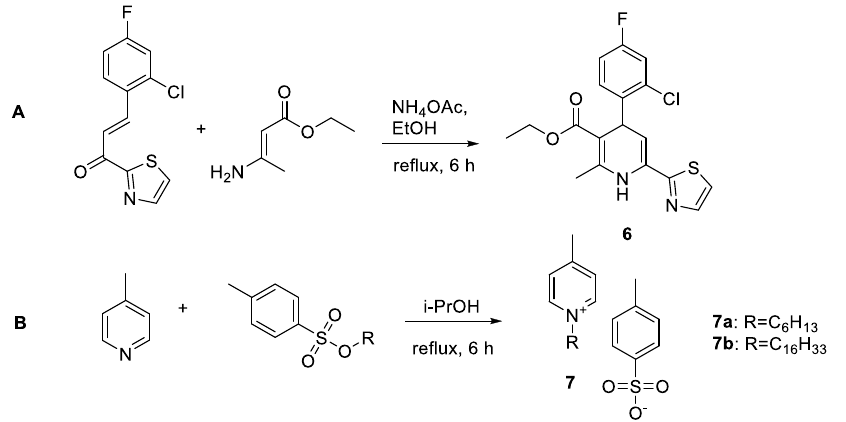
Figure 4. ( A ) Synthesis of heteroaryldihydropyridine 6 and ( B ) 1-alkyl-4-methylpyridin-1-ium 4- methylbenzenesulfonates 7 . Table 1. Compound structures, their toxicity, and effects on HBV capsid assembly. ( A ) — com-